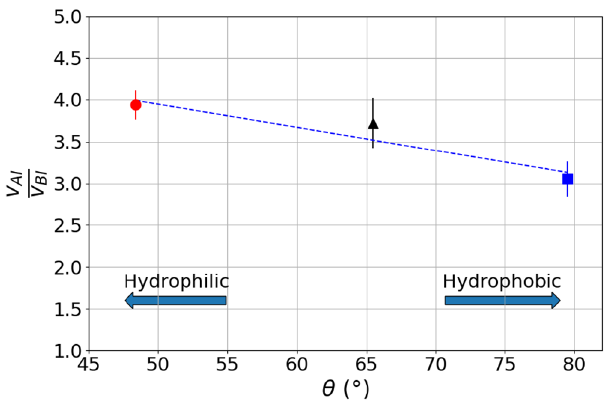
Fig. 6. Speed ratio as a function the contact angle θ . Trans- mission of kinetic energy decreases for more hydrophobic balls.